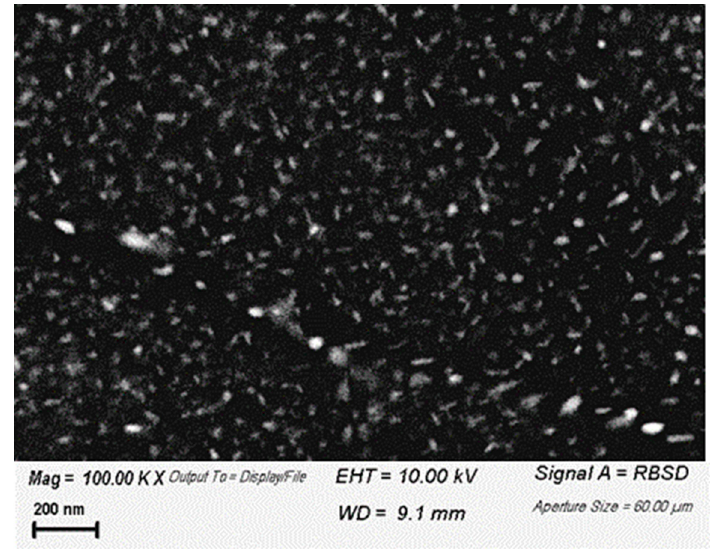
Figure 1. Example of the SEM-FEG high magnification (100 KX) image in sample A.